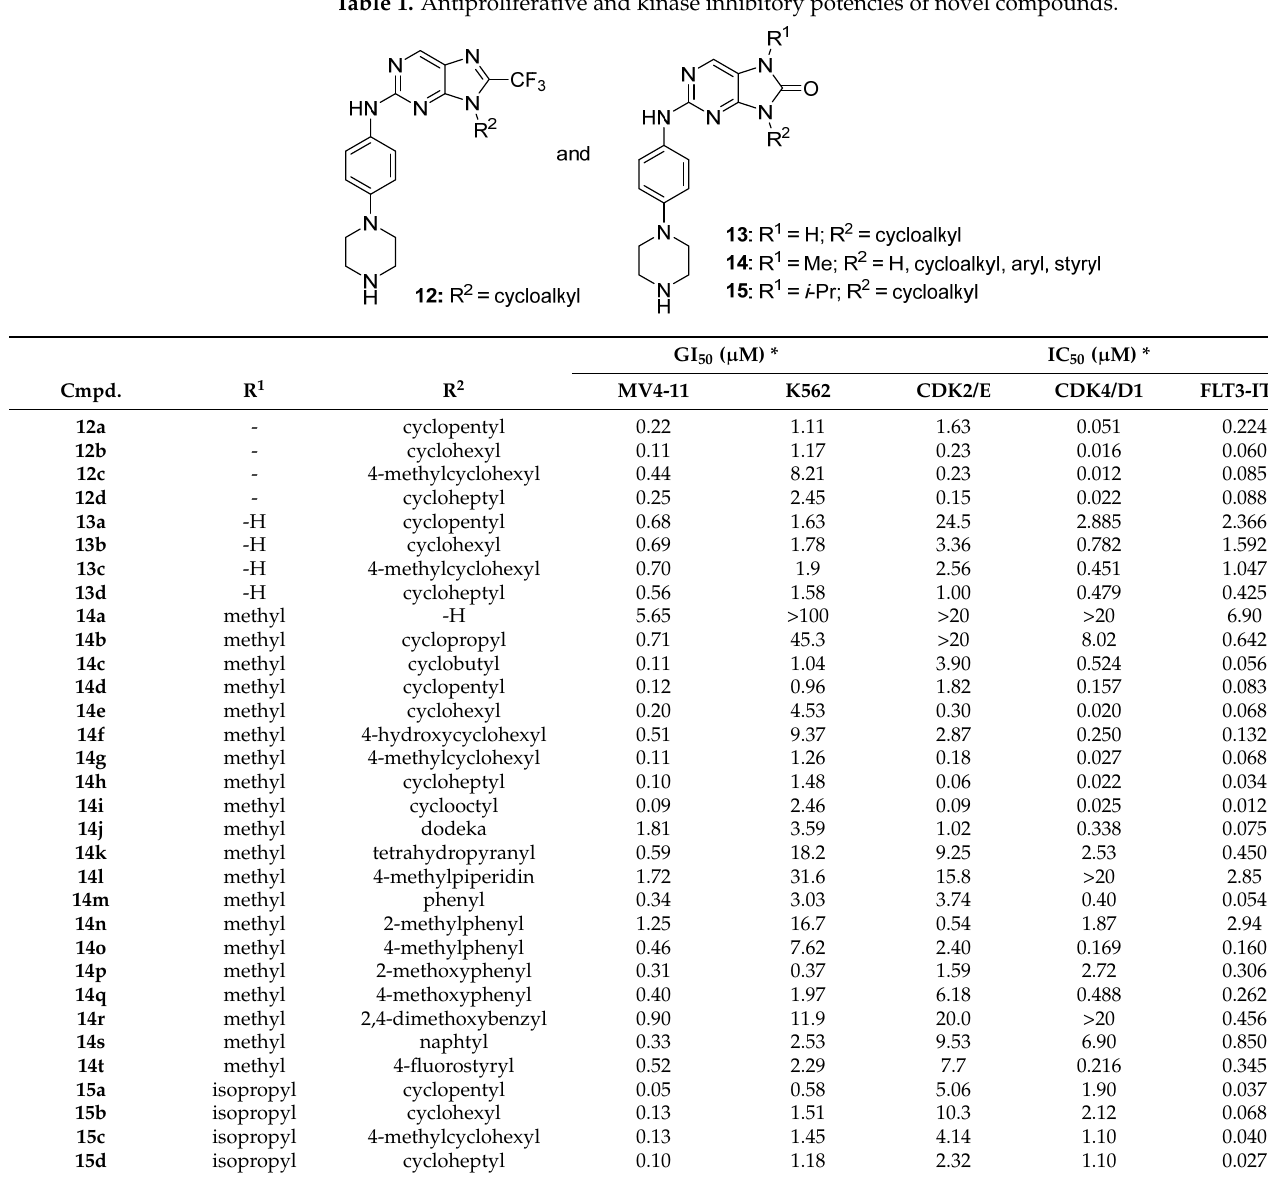
Table 1. Antiproliferative and kinase inhibitory potencies of novel compounds.